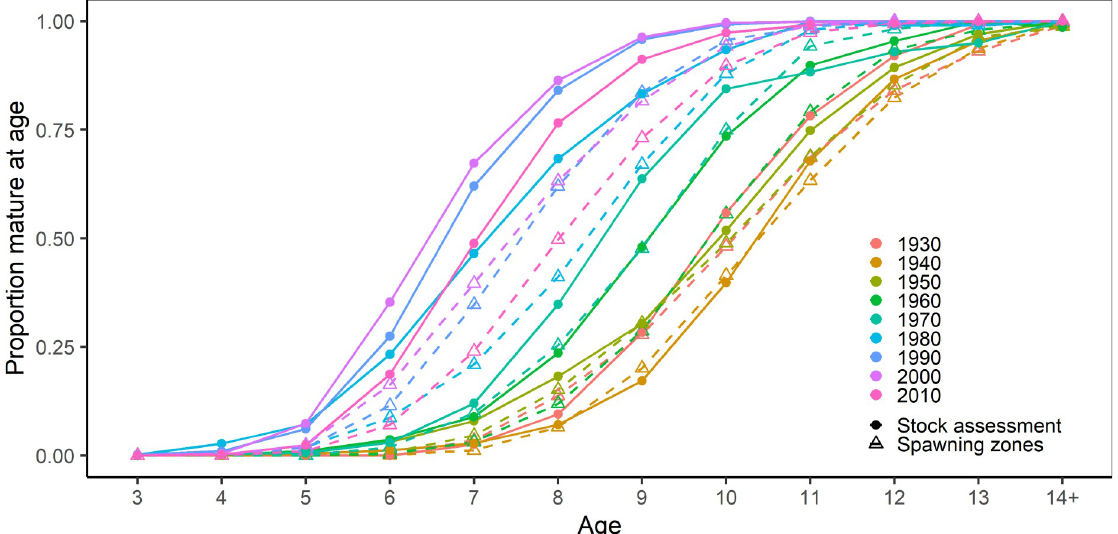
Fig 6. Maturity ogives of NEA cod extracted from stock assessment and reconstructed using individual spawning zones, aggregated by decade.